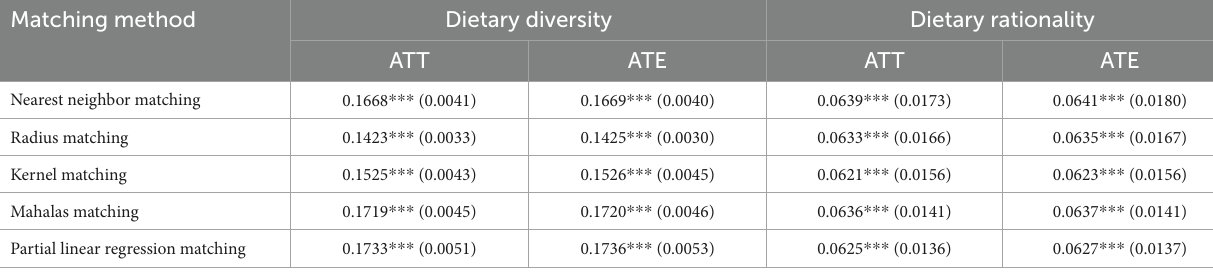
TABLE 4 Results of a PSM robustness test of the impact of Internet use on farm households’ diets.